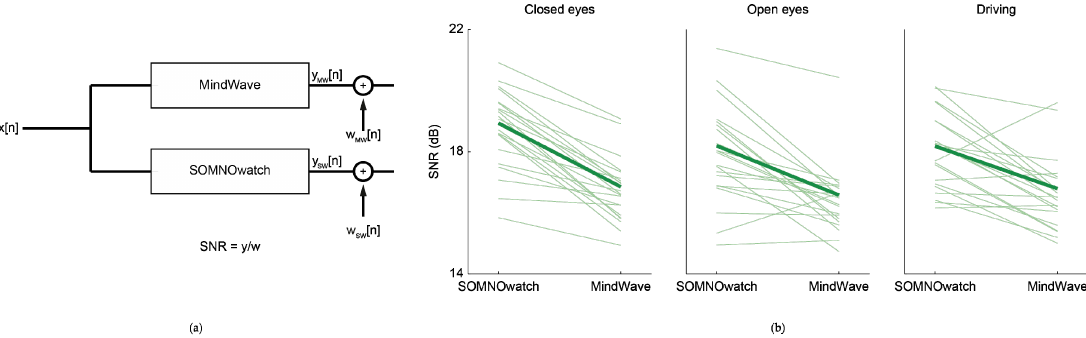
Figure 7. Signal-to-noise ratio (SNR) estimation. ( a ) Additive white noise model employed for the estimation of the SNR. The physiological signal x is filtered by the impulse response, resulting in filtered signal y , of both recording devices, at which point white noise ( w ) is added, resulting in the recorded signals. The SNR is defined as the ratio between the power of the filtered signal and the power of noise. ( b ) Results for each participant (thin lines) and average (thick line) the closed eyes ( left ), open eyes ( center ), and driving ( right ) tasks. SNR for the SOMNOwatch is on average 2 dB above that of the MindWave.